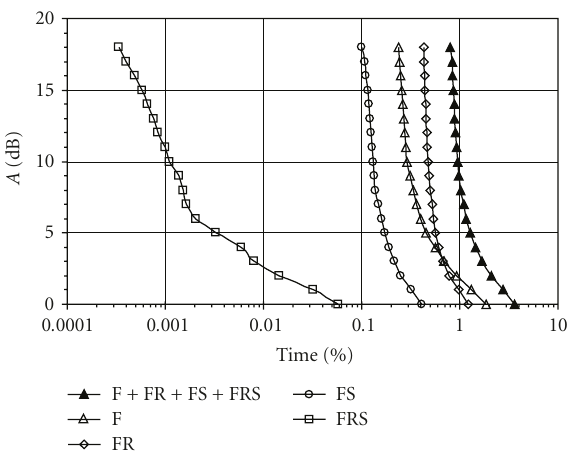
Figure 5: Obtained yearly CDs of attenuation due to all the hydrometeors combined on the RF path for the individual year periods.